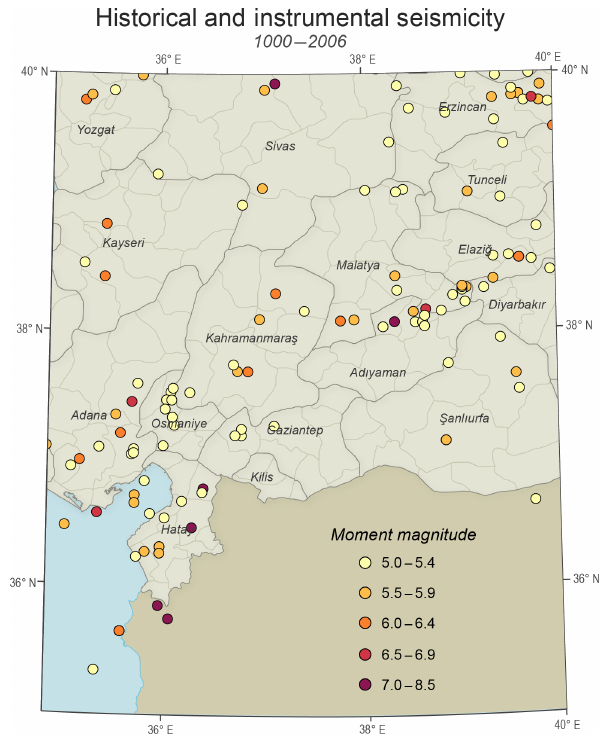
Figure 3. The distribution of earthquake shaking as gathered from historical documents and modern seismic networks, compiled in Sesetyan et al.